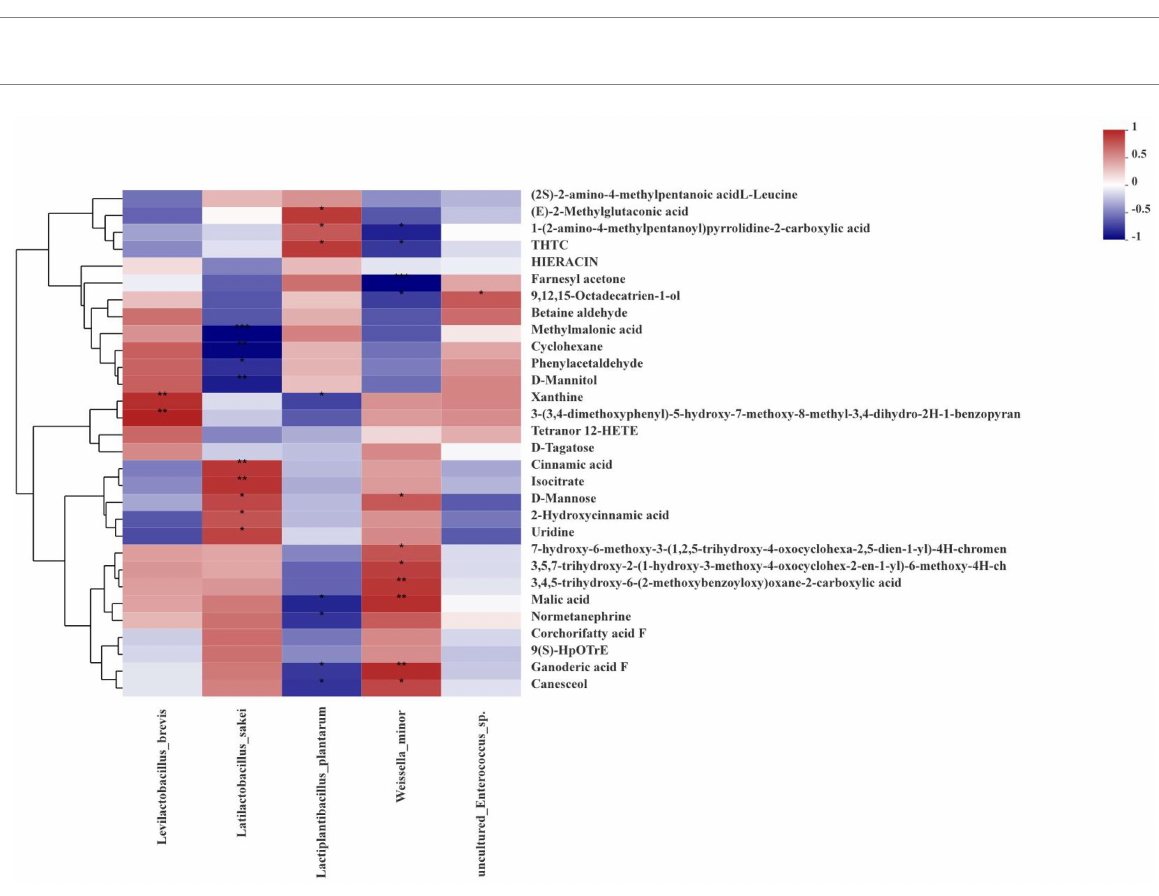
FIGURE 7 Correlation analysis of high abundance species-level bacteria and metabolites in silage at different growth stages. The corresponding values in the heat map are the Spearman correlation coefficients, r, which range between − 1 and 1; r < 0 indicates a negative correlation (blue), r > 0 indicates a positive correction (red), and ‘*’, ‘**’ and ‘***’ represent p < 0.05, p < 0.01, and p < 0.001,